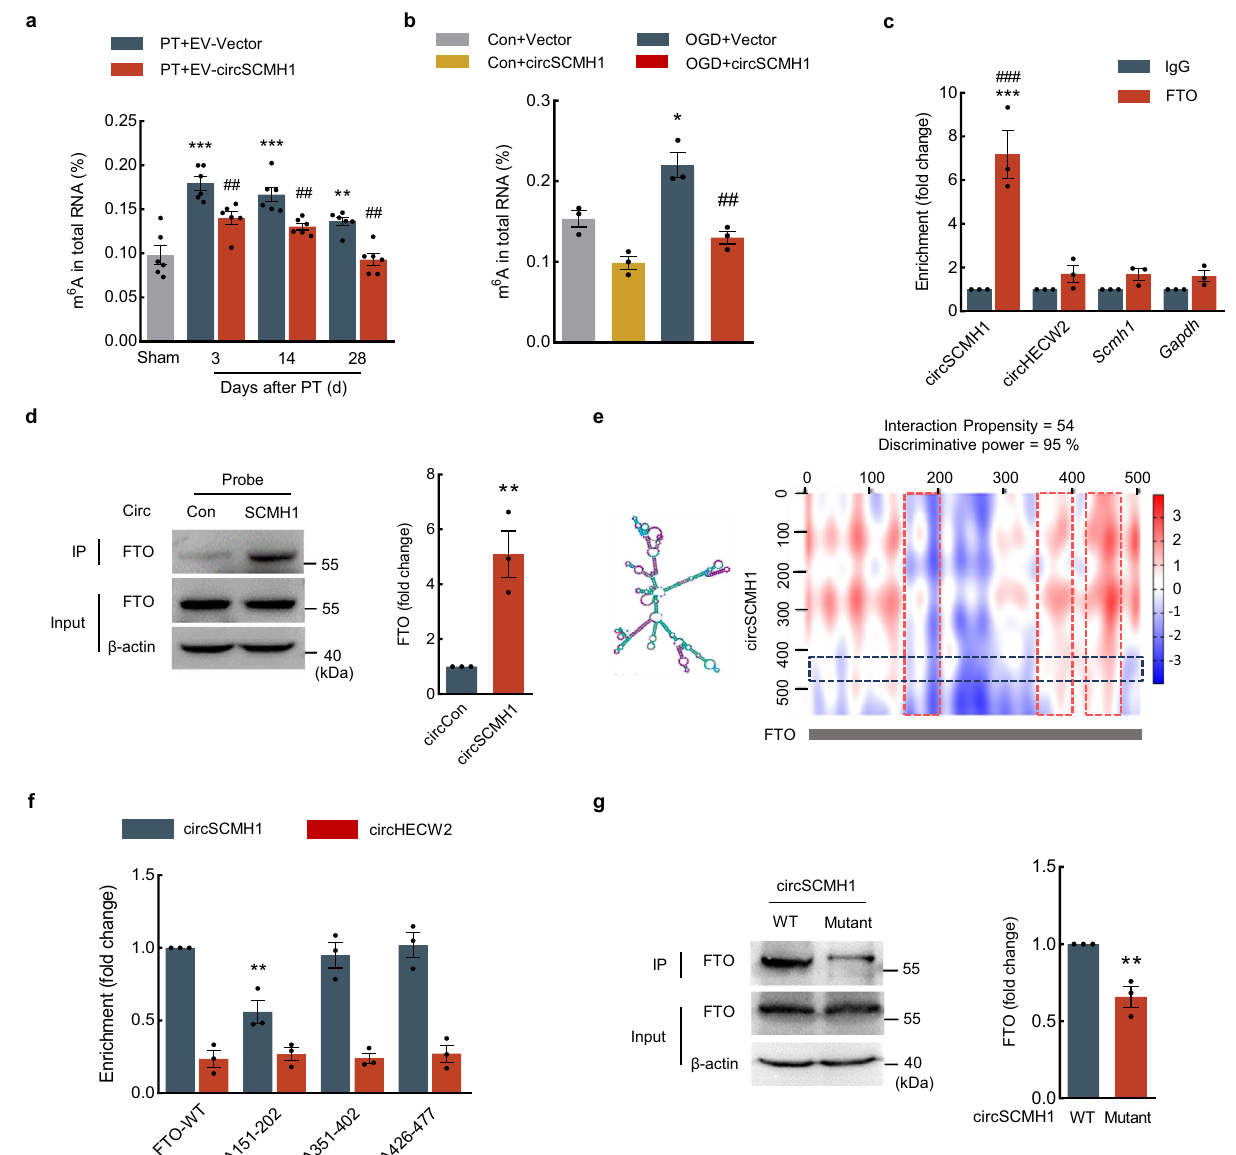
Fig. 3 | CircSCMH1 decreased m 6 A modi fi cation and bound with FTO. a Total RNA was extracted from the peri-infarct cortex of PT mice, m 6 A levels were determined as the percentage of all adenosine residues in RNA. n =6 mice/group. ** P =0.0072 (28d), *** P <0.0001 (3d, 14d) versus the sham; ## P =0.0056 (3d), ## P =0.0097 (14d), ## P =0.0024 (28d) versus the PT+EV-Vector. b Total RNA was extractedfromtheprimarymousebrainmicrovascularECstreatedwithcircSCMH1 plasmidat12hafter OGD,and m 6 A levelsweredetermined as the percentage of all adenosine residues in RNA. Data were presented by three independent experi- ments. * P =0.0231 versus Con+Vector; ## P =0.0051 versus OGD+Vector. c Interaction between circSCMH1 and FTO was detected by RNA-binding immu- noprecipitation in the primary brain microvascular ECs. Data were presented by three independent experiments. *** P <0.0001 versus FTO pull-down ofcircHECW2; ### P <0.0001 versus FTO pull-down of Gapdh mRNA. d Interaction between circSCMH1 and FTO was measured by RNA pull-down assay in the primary mouse brain microvascular ECs. Data were presented by three independent experiments. ** P =0.0085 versus the circCon probe. e Prediction of circSCMH1-FTO interaction